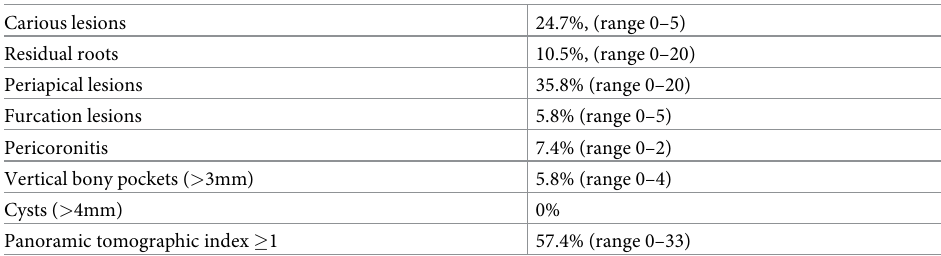
Table 2. Panoramic radiograph findings.